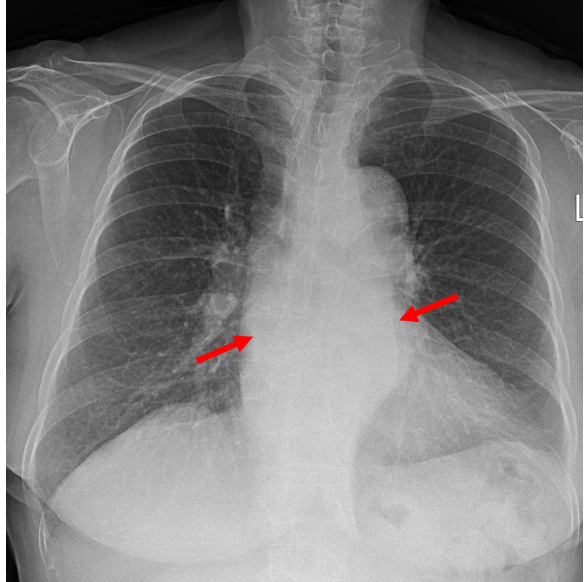
Figure 3. A 76-year-old woman with acute phlegmonous esophagitis. Chest posteroanterior radio- graph obtained 5 days after the initial CT image shows mass-like opacity (arrows) that obscured both paravertebral stripes, suggestive of a posterior or paravertebral mass lesion.